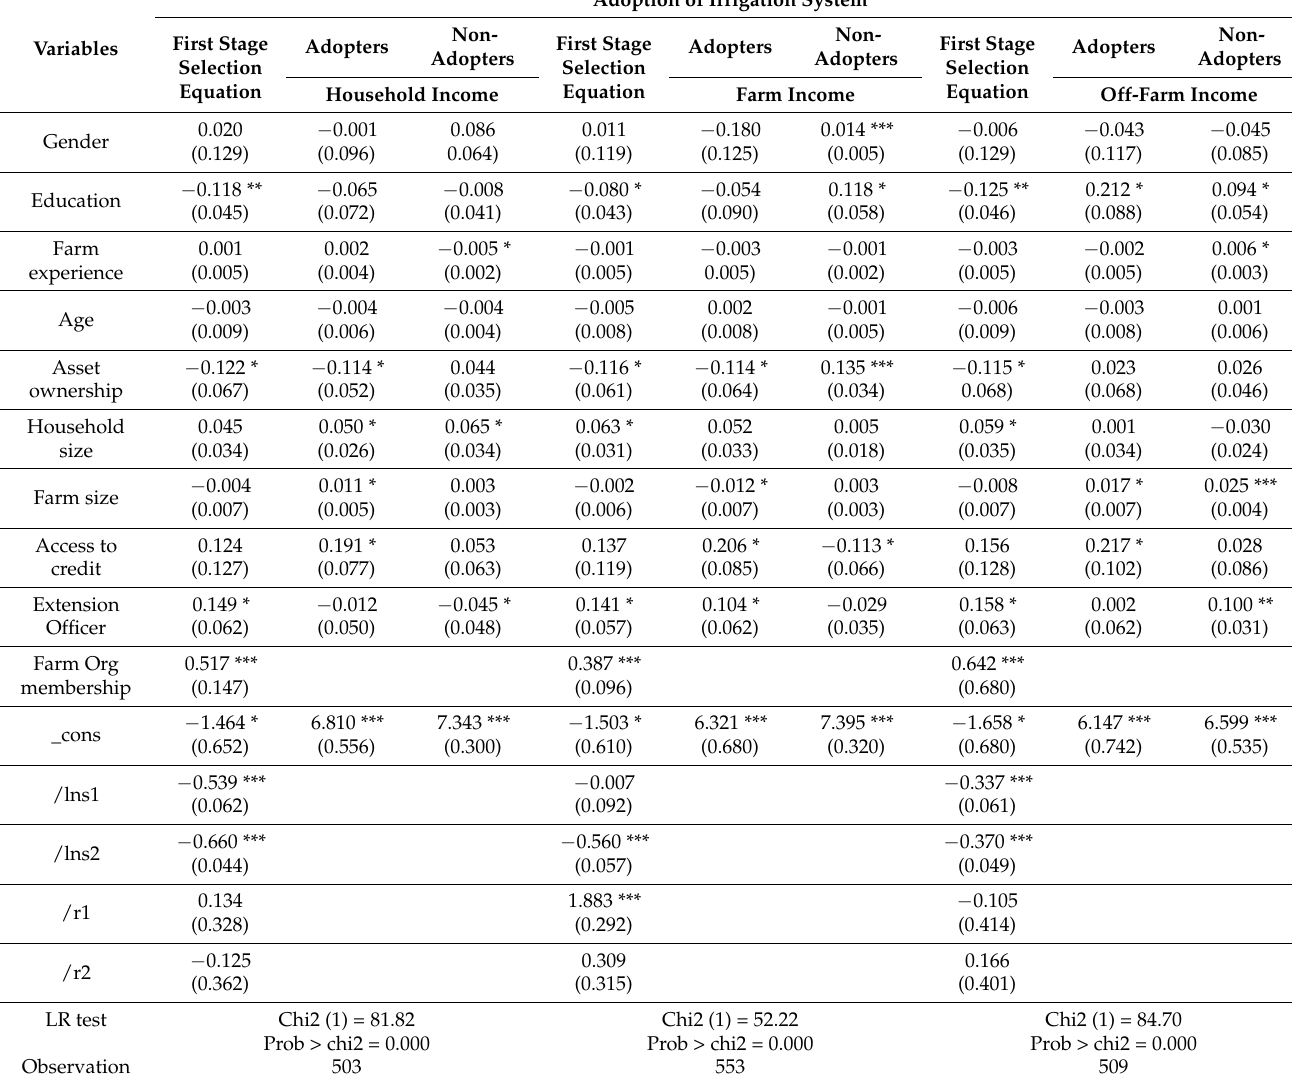
Table 6. Endogenous switch regression model estimation on adoption of irrigation system on income levels of cocoa